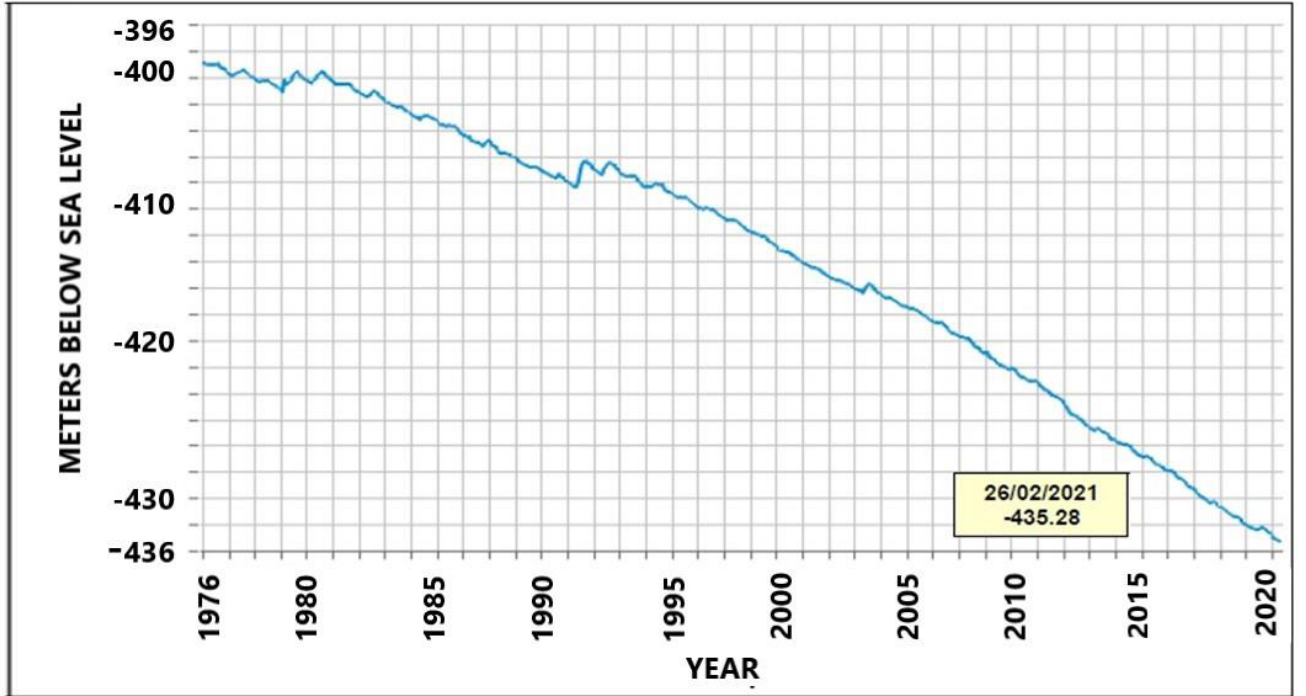
Figure 2. Change in Dead Sea level 1976–2021. Source: adapted from IWA, 2022. https://www.gov.il/he/Departments/General/dead-sea-stats (accessed on 14 January 2022)